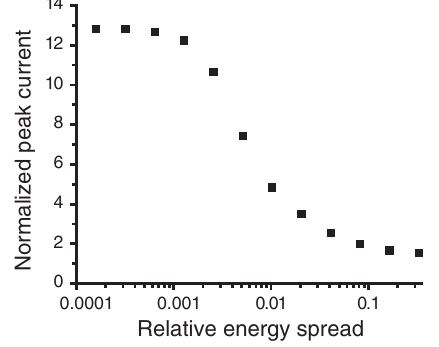
FIG. 5. Peak current vs initial energy spread.